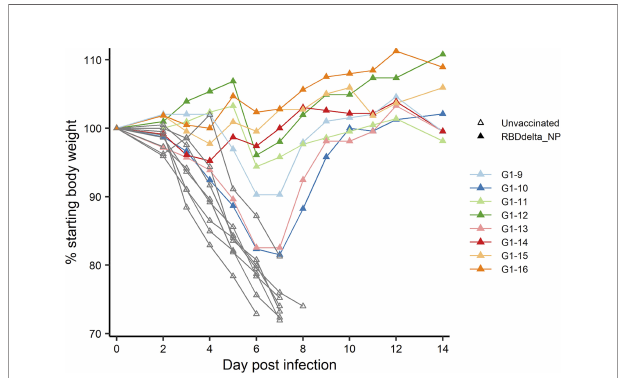
FIGURE 7 | Individual clinical score 0-14 dpi: Daily individual clinical score of infected K18-hACE2 transgenic mice. Each offour criteria (ruf fl ed fur, hunched posture, reduced locomotion and dif fi cult breathing) received a 0-3 score and were added into a global score. Immunized Group 1 (n= 8) is with individual color code and unvaccinated Group 2 (n= 8) is in